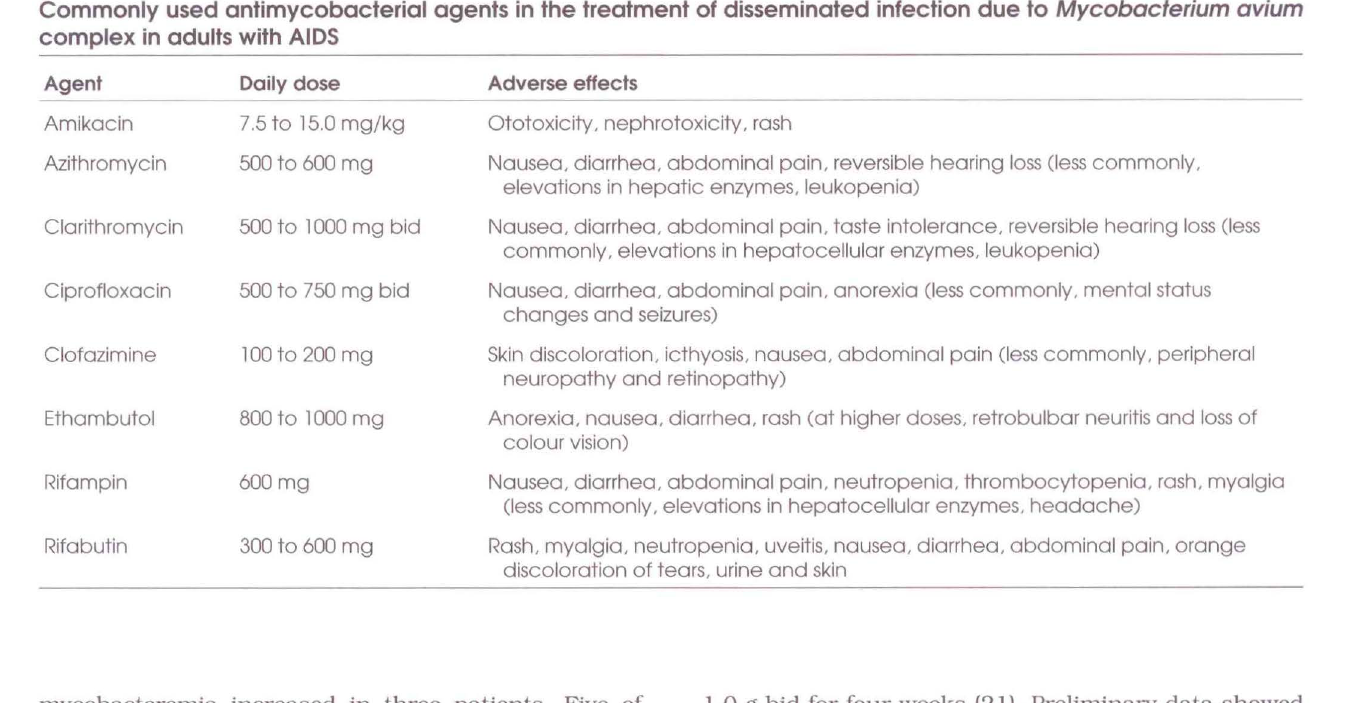
Commonly used antimycobacterial agents in the treatment of disseminated infection due to Mycobacterium avium complex in adults with